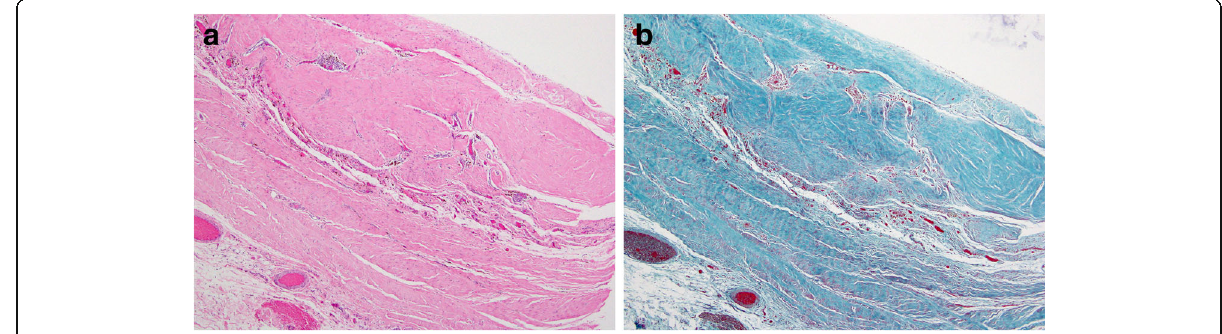
Fig. 2 Pathological examination revealed fibrosis and scar formation in the thickened pericardium. Mild perivascular infiltration of T-lymphocytes was observed. Collagen fiber complex formation was increased as demonstrated by a finding of hyalinization. Edematous changes or fibrin precipitation were not observed. a Hematoxylin-eosin staining. b Elastica-Masson